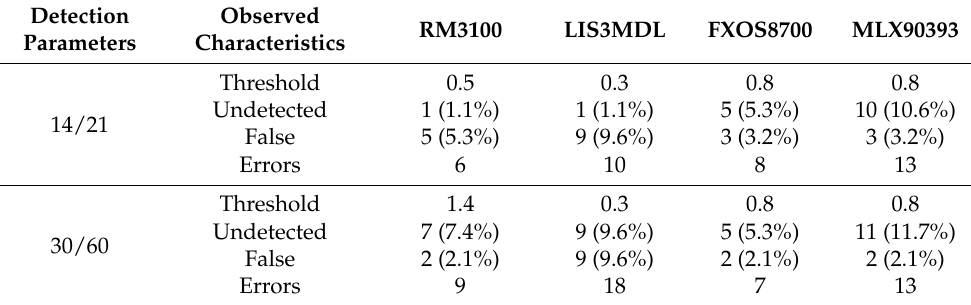
Table 7. Optimal threshold level and detection results for measurement